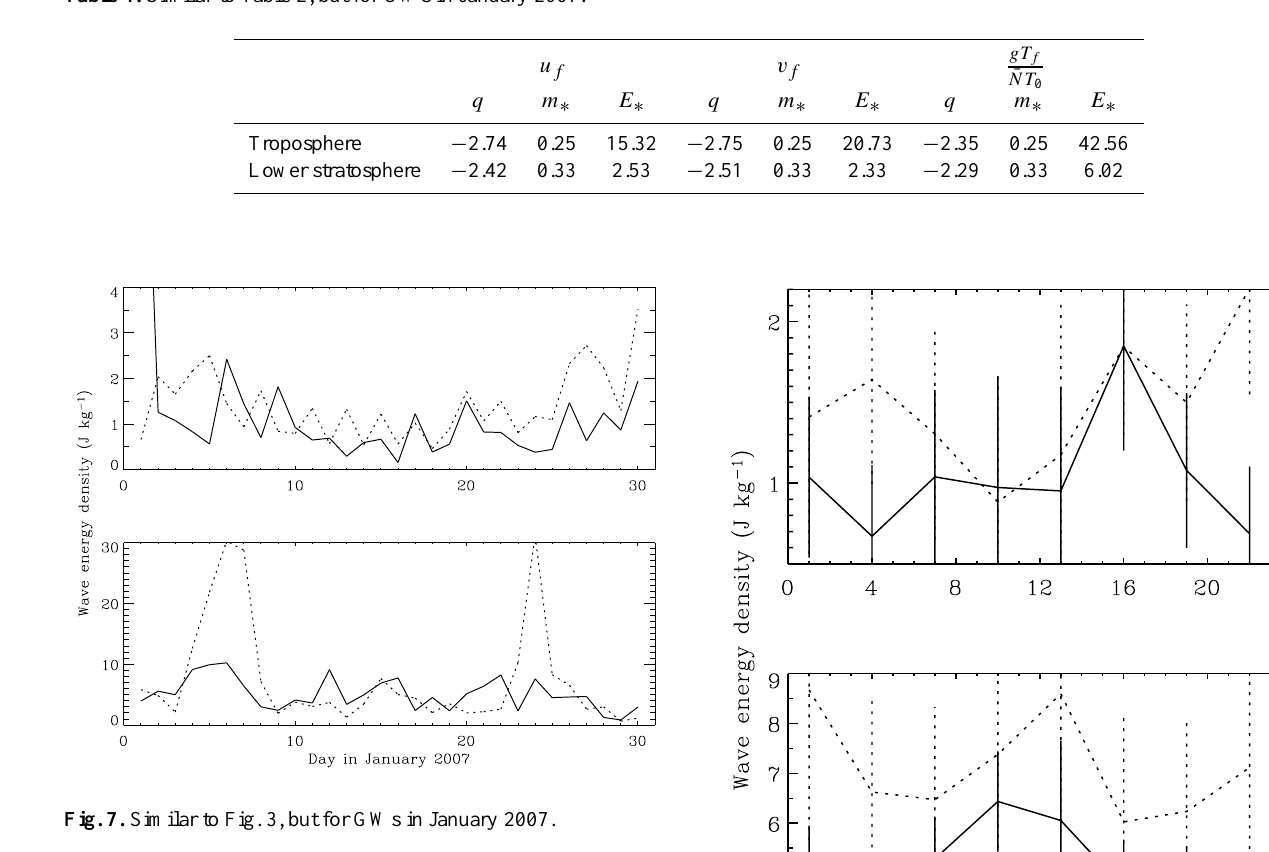
Table 4. Similar to Table 2, but for GWs in January 2007.